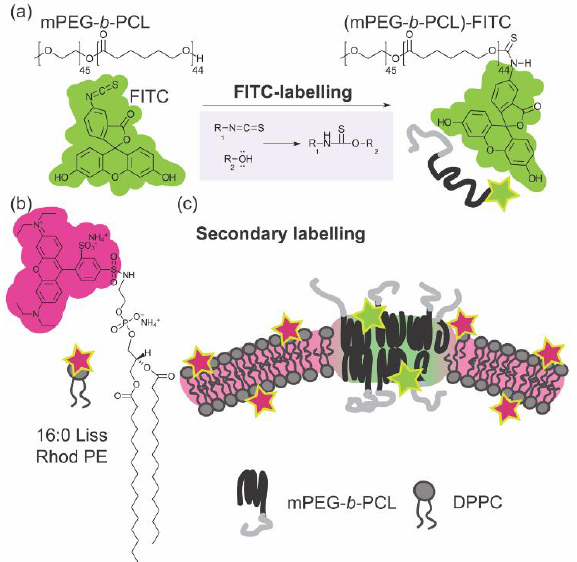
Figure 2. Scheme of ( a ) a fluorescent labelling chemistry of fluorescein isothiocyanate (FITC) with mPEG- b -PCL, ( b ) structure of 16:0 Liss Rhod PE (or Rhod B PE), and ( c ) secondary fluorescent labelling mechanism in DPPC – mPEG- b -PCL hybrid membrane using (mPEG- b -PCL)-FITC and 16:0